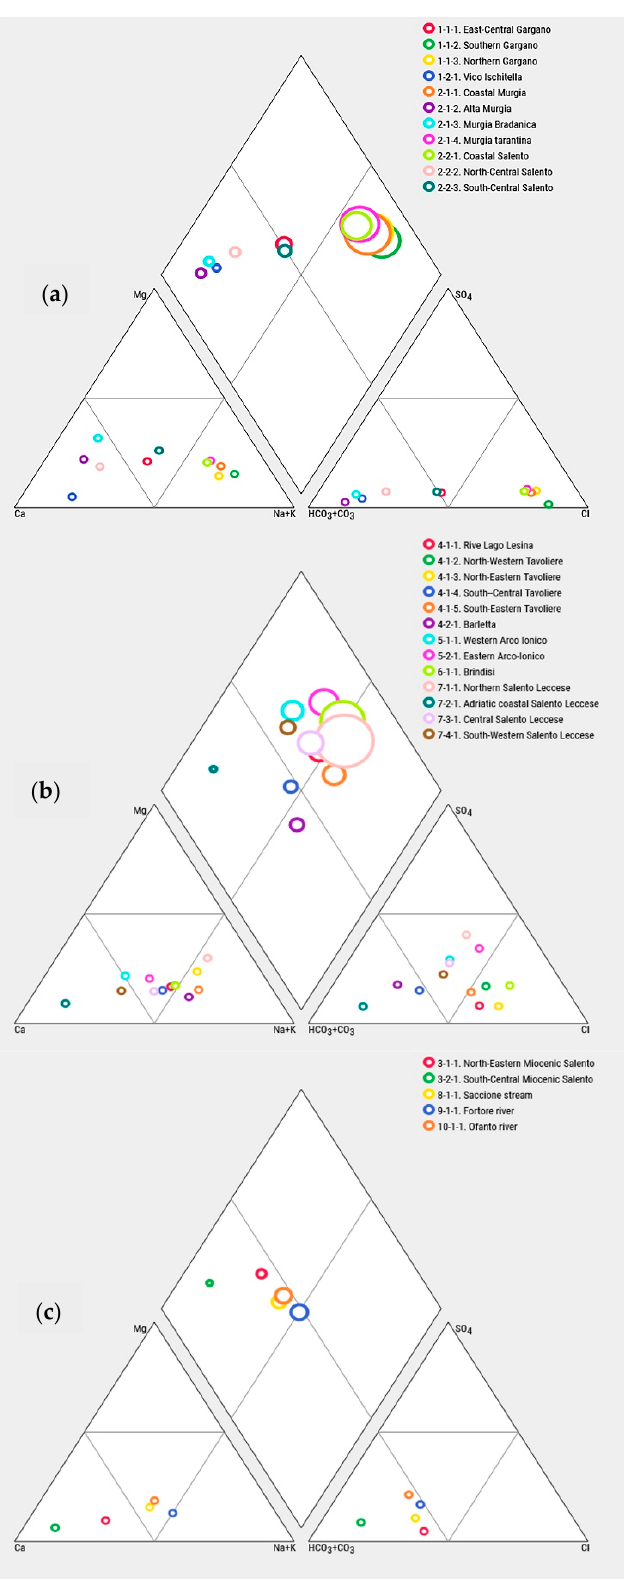
Figure 5. Piper diagrams showing major groundwater components ( a ) Gargano and Murgia-Salento carbonate HCs; ( b ) detrital HCs; ( c ) Alluvial and Miocene carbonate HCs.